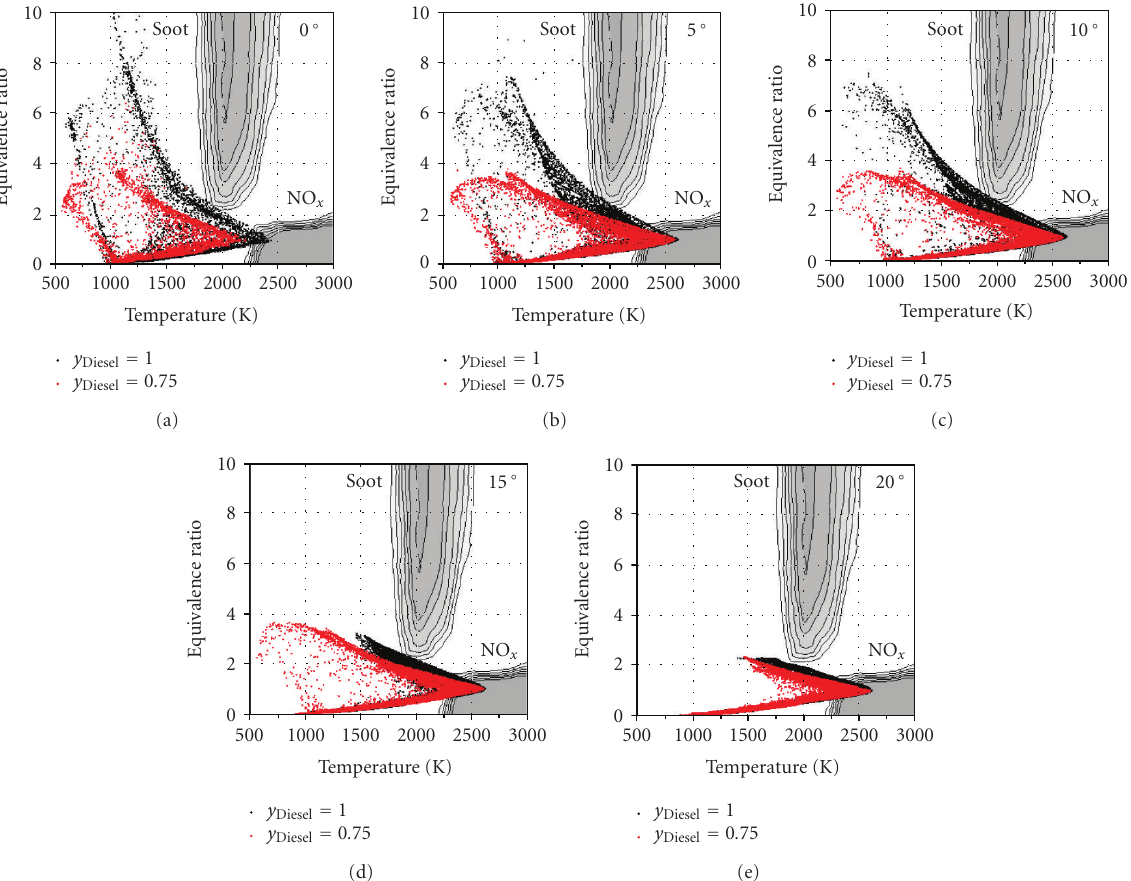
Figure 18: Equivalence ratio-temperature plots for pure diesel fuel and a 25% emulsion; Soot and NO x formation maps according to [13].